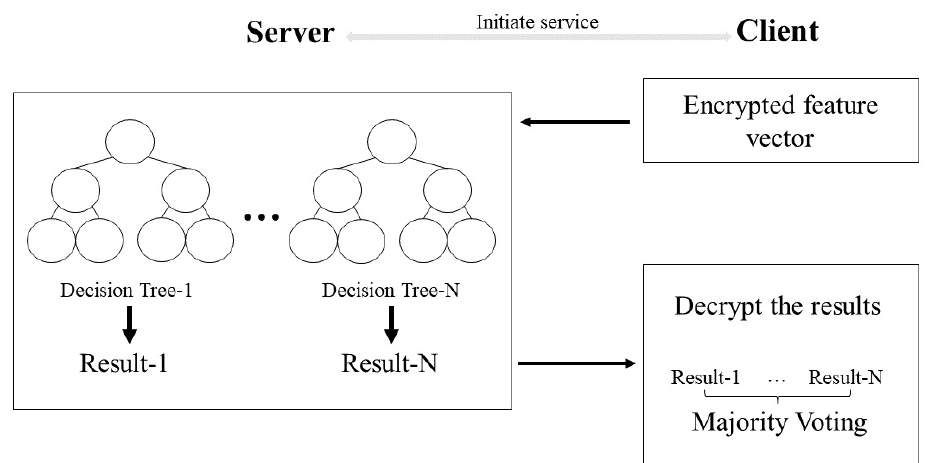
Figure 5. Random forest.